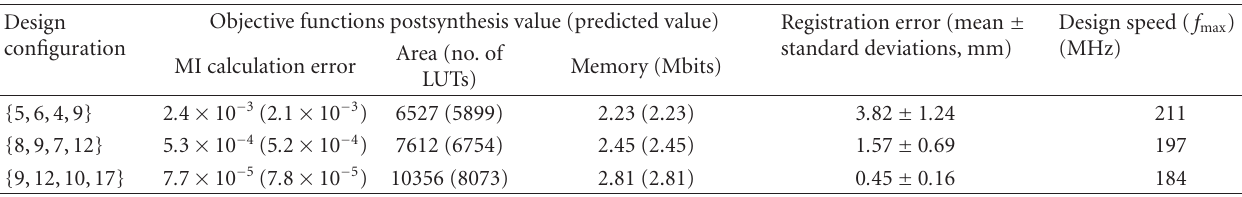
Table 4: Validation of the objective function models using postsynthesis results. The wordlengths in a design configuration correspond to the FWLs of the design variables identified earlier (see Table